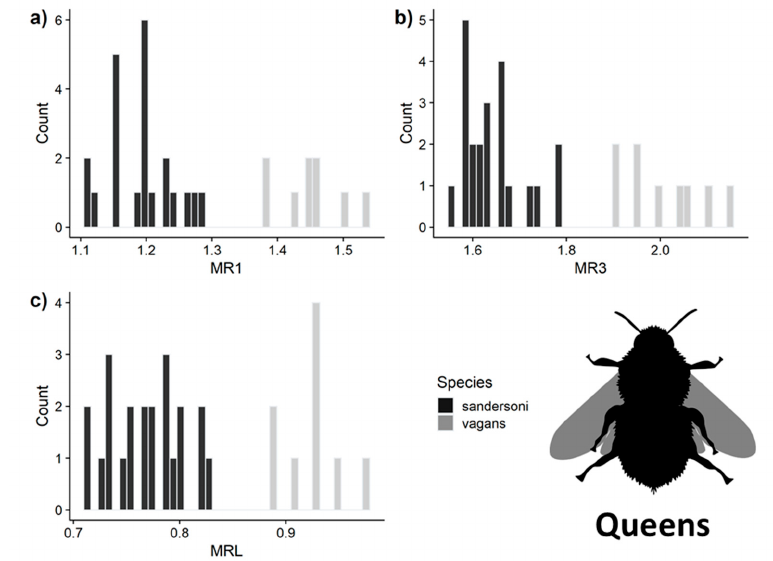
Figure 4. Distribution of malar ratio measurements of queens used in the linear discriminant analysis (LDA) for ( a ) malar length to flagellar segments 1 (MR1), ( b ) MR3 and ( c ) MRL. All three measurements had 100% accuracy for predicting species identities on subsampled datasets. Image from phylopic.org.